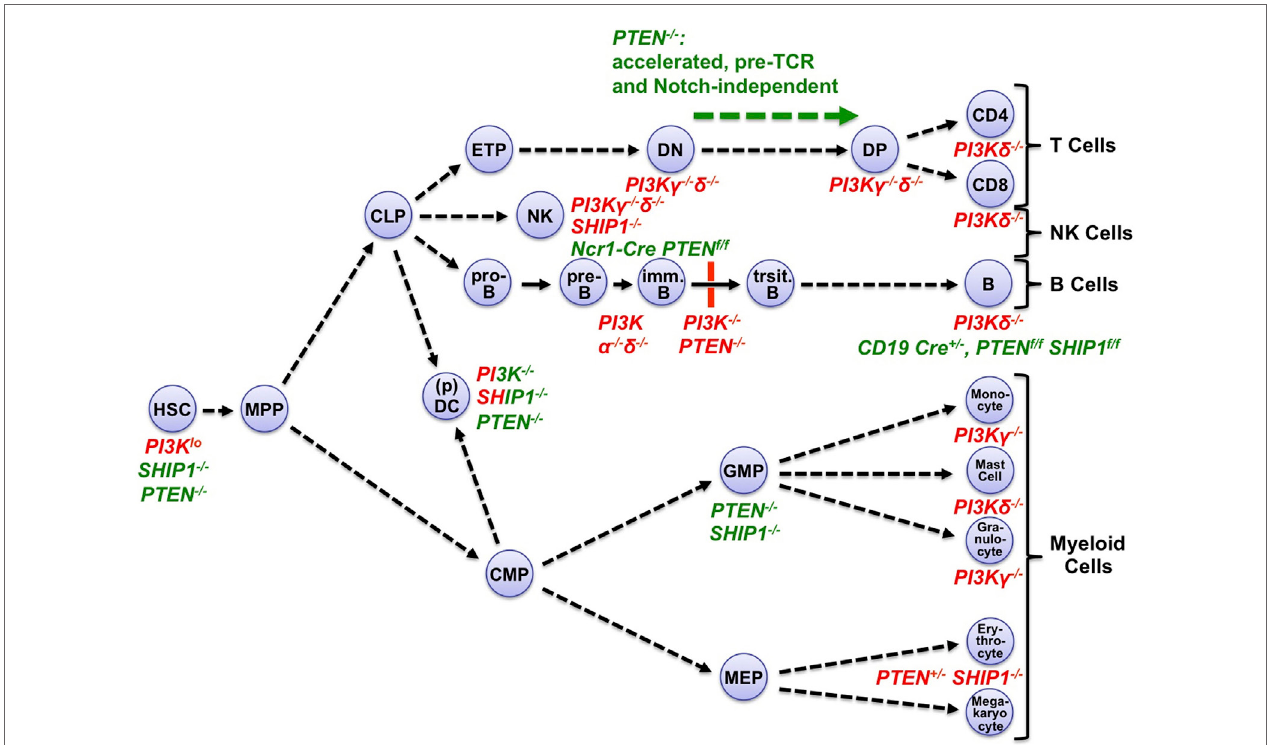
FigURe 2 | Phosphoinositide 3-kinase (PI3K) loss-of-function or gain-of-function affects multiple stages of hematopoietic development, and mature hematopoietic cells. Hematopoiesis originates from quiescent, long-lived, and pluripotent hematopoietic stem cells (HSC) which reside in BM (BM) niches with low-metabolic and cell cycle activity (26, 30). After occasional division and activation, HSC daughter cells can differentiate through multiple hematopoietic progenitor cell stages including multipotent progenitors (MPP) into lymphoid or myeloid lineages. During lymphopoiesis, MPP-derived common lymphoid progenitors (CLP) give rise to the T cell, NK cell, and B cell lineages. CLP can also generate subsets of dendritic cells (DC), in particular plasmacytoid DC (pDC). CLPs initiate the B/T cell lineages through early thymic progenitors (ETP) and pro-B cells, respectively. ETPs develop through CD4 − CD8 − (DN) and CD4 + CD8 + (DP) stages into mature T cells. In the bone marrow, pro-B cells develop via pre-B cells into immature B cells. These translocate into the spleen to mature through transitional stages into mature B cells. In myelopoiesis, MPP-derived common myeloid progenitors (CMP) give rise to granulocyte–monocyte progenitors (GMP) which in turn generate granulocytes, monocytes, and mast cells. Alternatively, CMP can give rise to megakaryocyte–erythrocyte progenitors (MEP), which in turn generate megakaryocytes and erythrocytes. CMP can also generate common DC precursors, which in turn generate most DC subsets (31). The map indicates major hematopoietic progenitors and mature cell types that are negatively (red font) or positively (green font) affected in mice deficient for the indicated PI3K isoforms, SHIP-1 , or PTEN (4–9, 26, 30–34). Mixed red–green font indicates complex phenotypes with activation and inactivation components. Immune cells express multiple class I PI3K isoforms. Among those, mature T cell, B cell, NK cell, and mast cell functions or chemotaxis are particularly dependent on the protein tyrosine kinase-dependent receptor- activated PI3K δ with contributions by the GPCR-activated PI3K γ (32, 33). Monocyte/macrophage and granulocyte chemotaxis is critically dependent on PI3K γ , with contributions by PI3K δ and, in macrophages and neutrophilic granulocytes, PI3K β (33, 35). DC require PI3K γ and δ for various aspects of their function (33). For detailed recent reviews of PI3K isoform functions in hematopoietic cells, see Ref. (32,